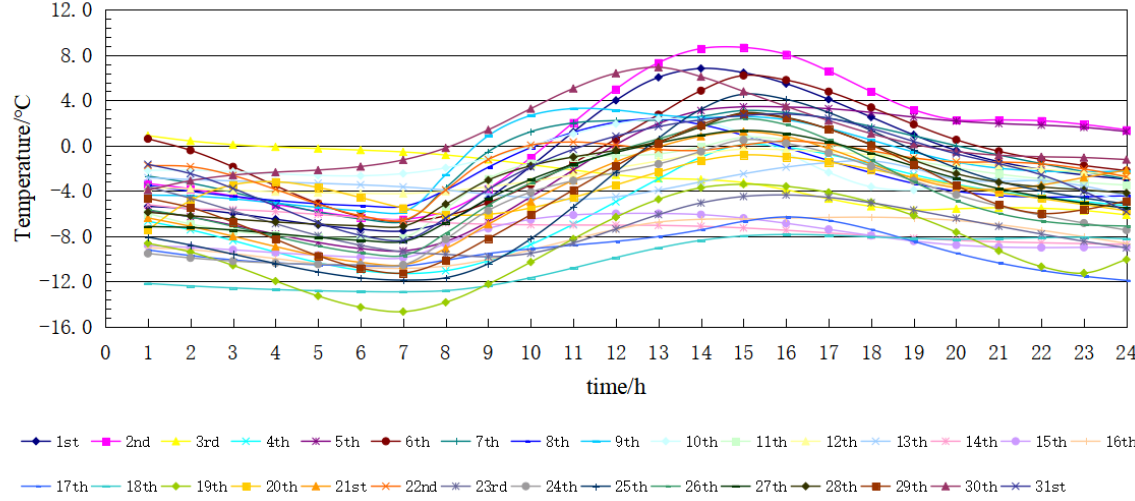
Figure 2. Average annual hourly temperature for the days in January in Beijing.